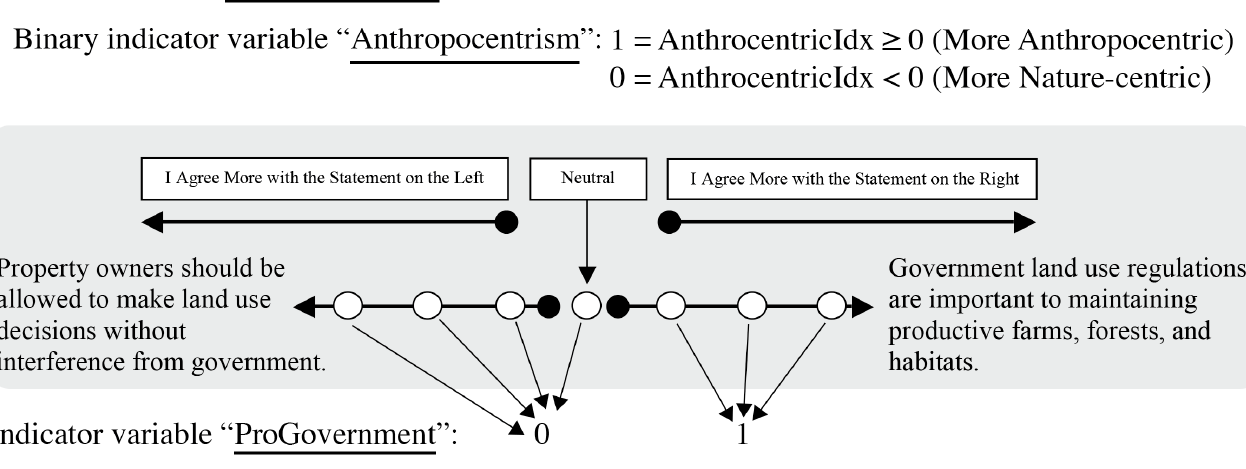
Figure 6. Survey sections querying anthropocentrism and attitudes toward government.